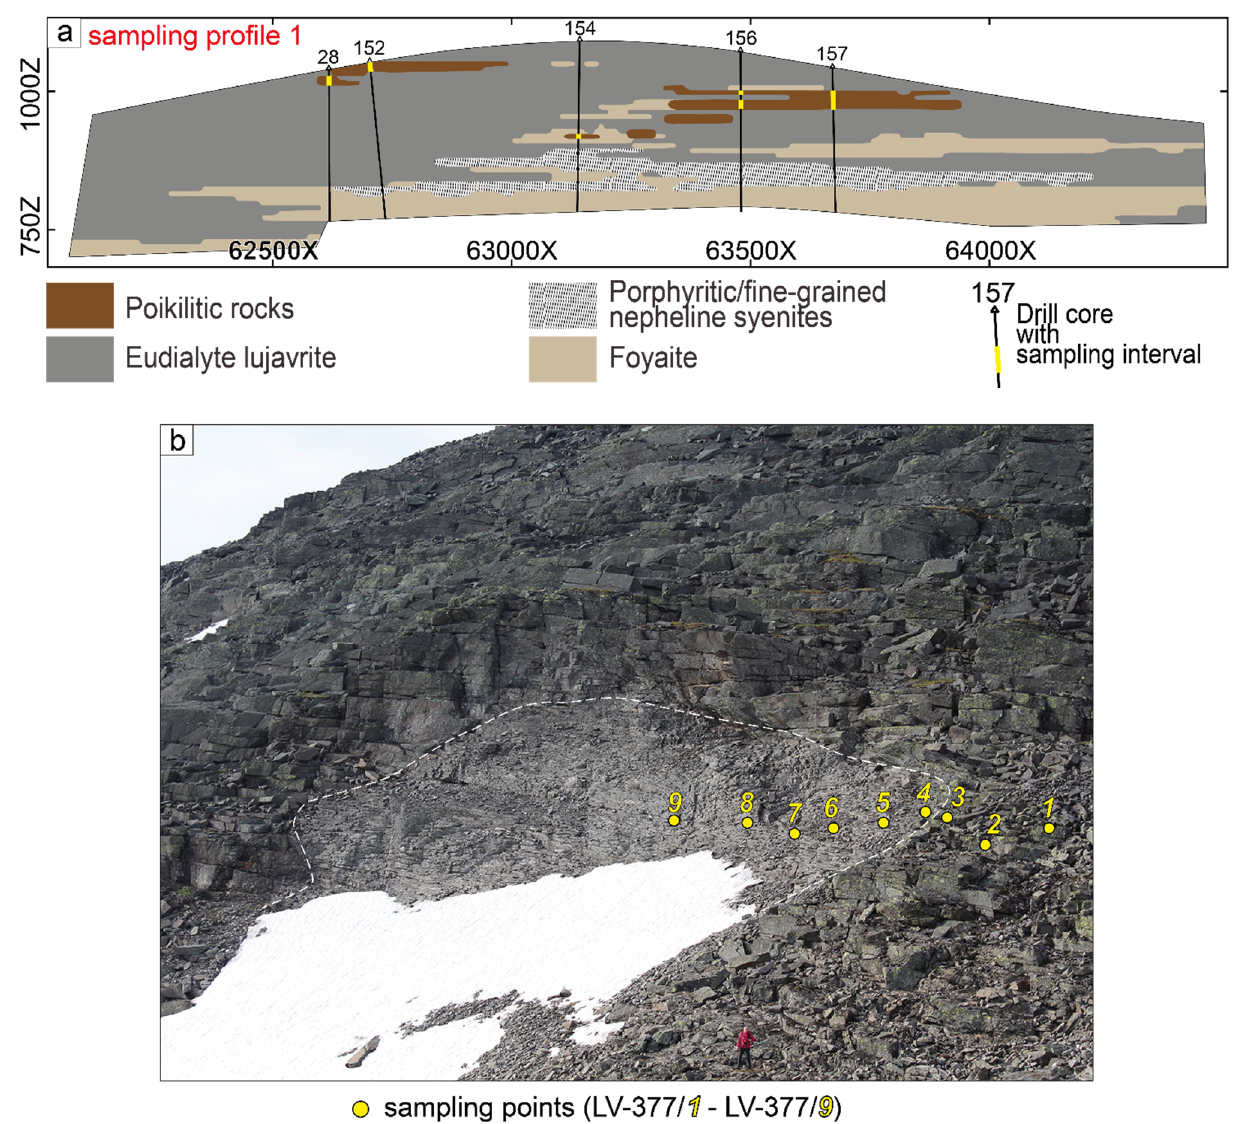
Figure 3. ( a ) Schematic cross section along sampling profile 1 [54]. Only those wells from which samples were used in this article are shown. The lenses of the poikilitic rocks are located near the foyaite or at the same level. ( b ) Outcrop (LV-377) of poikilitic rocks within sampling area 2. Poikilitic rocks form a lens-like body (outlined by a white dashed line) among eudialyte lujavrite.